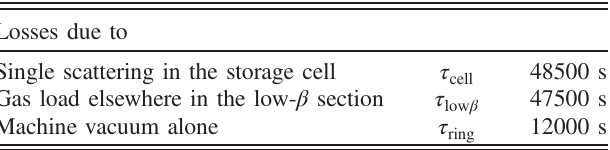
TABLE VI. Contributions to the total beam lifetime of τ 8000 s during the spin-filtering experiments with polarized target ¼ 5 . 5 × 10 13 cm − 2 with d t